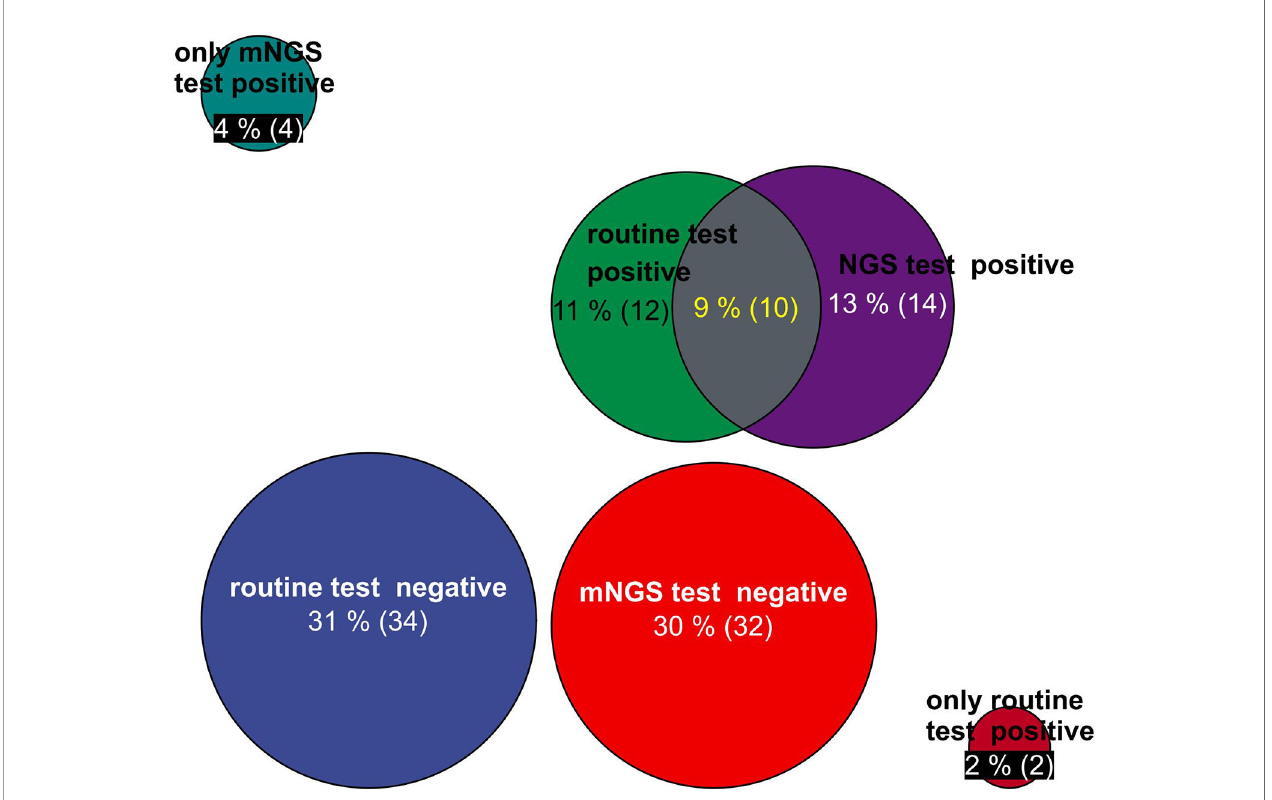
FIGURE 2 | Circle chart of statistics on the number of patients detected by mNGS and conventional technology. The patients were divided into fi ve groups for statistics: the number of positive patients only by routine test, the number of positive patients only by mNGS test, the number of positive patients by routine test and mNGS test, the number of negative patients by mNGS test, and the number of negative patients by routine test. mNGS, metagenomic next-generation sequencing.